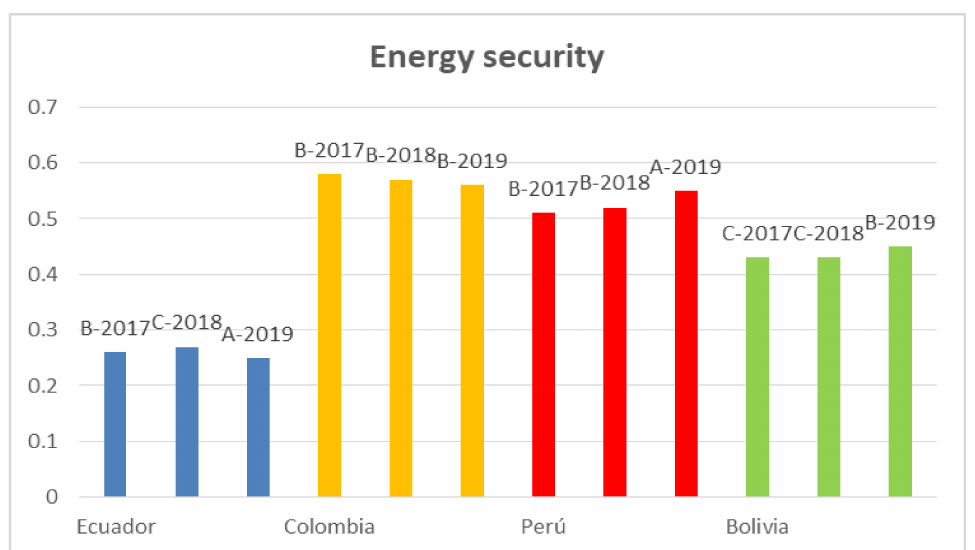
Figure A1. Energy security dimension by countries in period from 2017 to 2019. A,B,C,D—letter indices according to the WEC methodology: The letter A indicates the highest grade, the letter D—the lowest for each of the dimension.